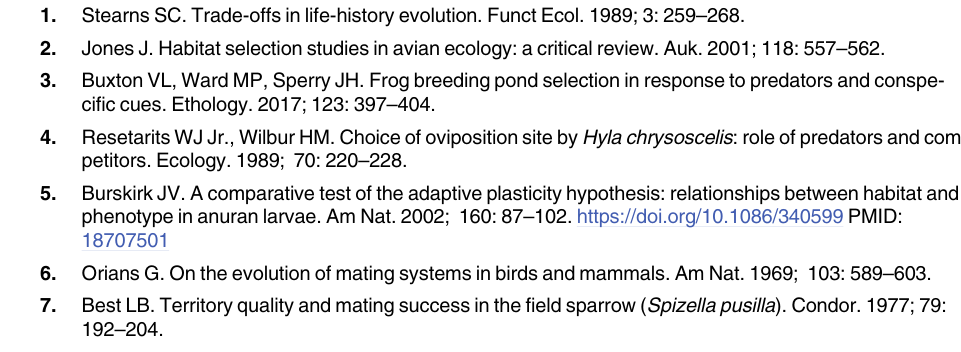
S1 Table. Raw data. MinD = minimum diameter; MaxL = maximum central tank length, NA = data not available. S2 Table. AICc tables for all candidate models. S3 Table. Cross-correlations between explanatory variables. (XLSX) S4 Table. Raw data on frequency of bromeliads with Aparasphenodon arapapa males (used bromeliads) and without (not used bromeliads) according to the systematic sample. N val- ues show the number of plants in each category. 0 = no litter/upright plants; 1 = small amount of litter/slightly inclined plants; 2 = large amount of litter but not enough to prevent an indi- vidual of the anuran from passing through the central tank/ heavily inclined; 3 = very large amount of litter with no passage free through central tank/ it is not a category to